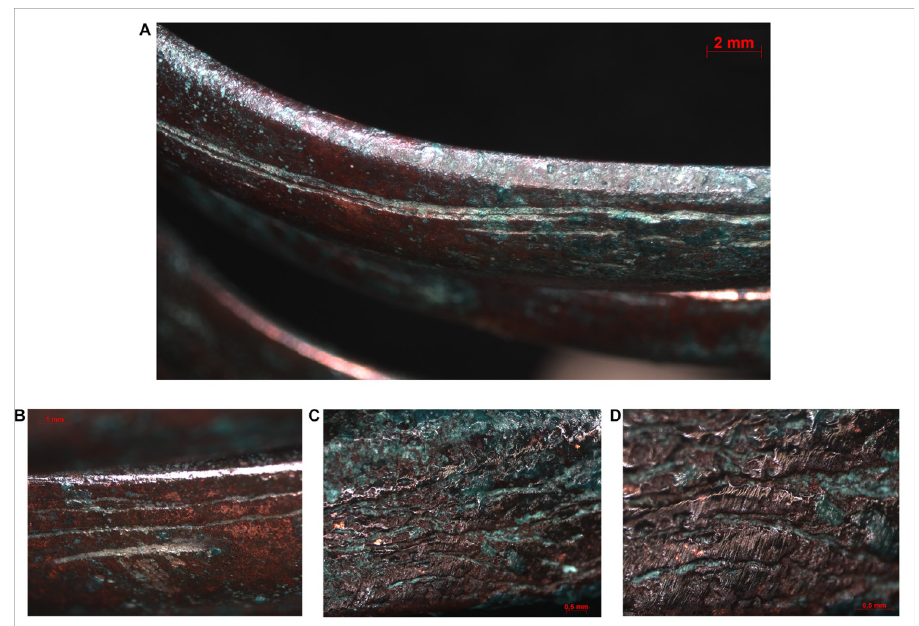
Fig 15. Micrographs showing the macrostructure of spiral bracelets. Photo: Eszter Horva´th. (A–D) Parallel lines visible on the surface of the spiral coils suggest a laminate structure (A–B. O˝.2019.8.1.244., C–D. O˝.2019.8.1.243.).